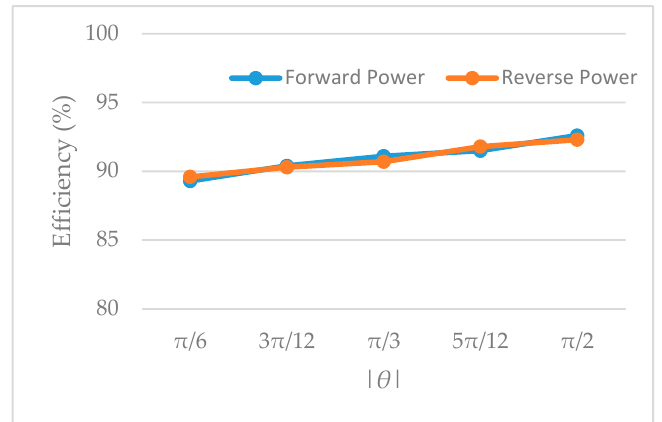
Figure 15. Efficiency of the system. Figure 15. E ffi ciency of the